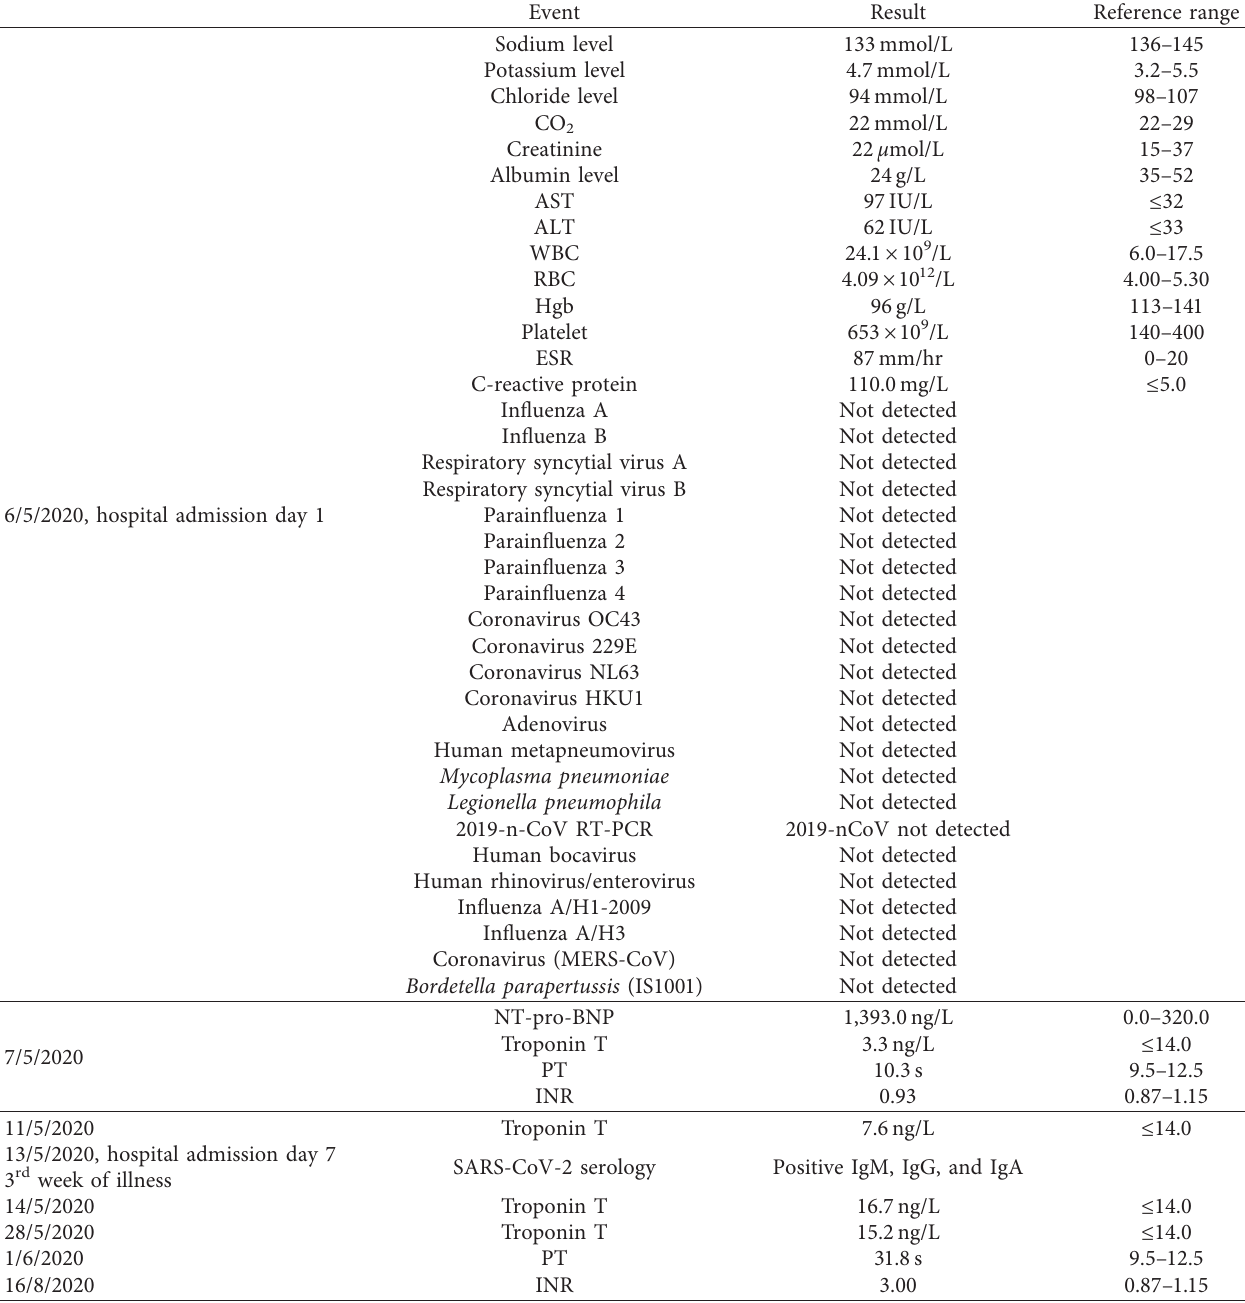
Table 1: Laboratory